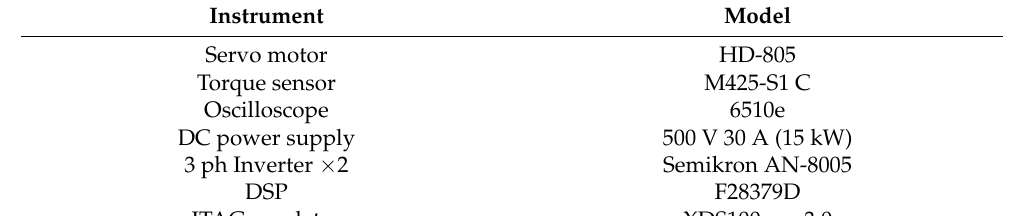
Figure 11. Manufactured motor: ( a ) stator; ( b ) rotor. Figure 12. Experimental setup for testing.